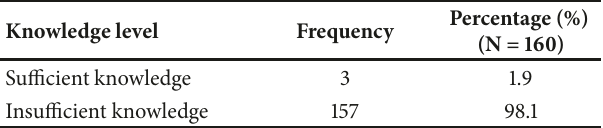
Table 4: Knowledge of midwives on appropriate interventions to carry out on distressed